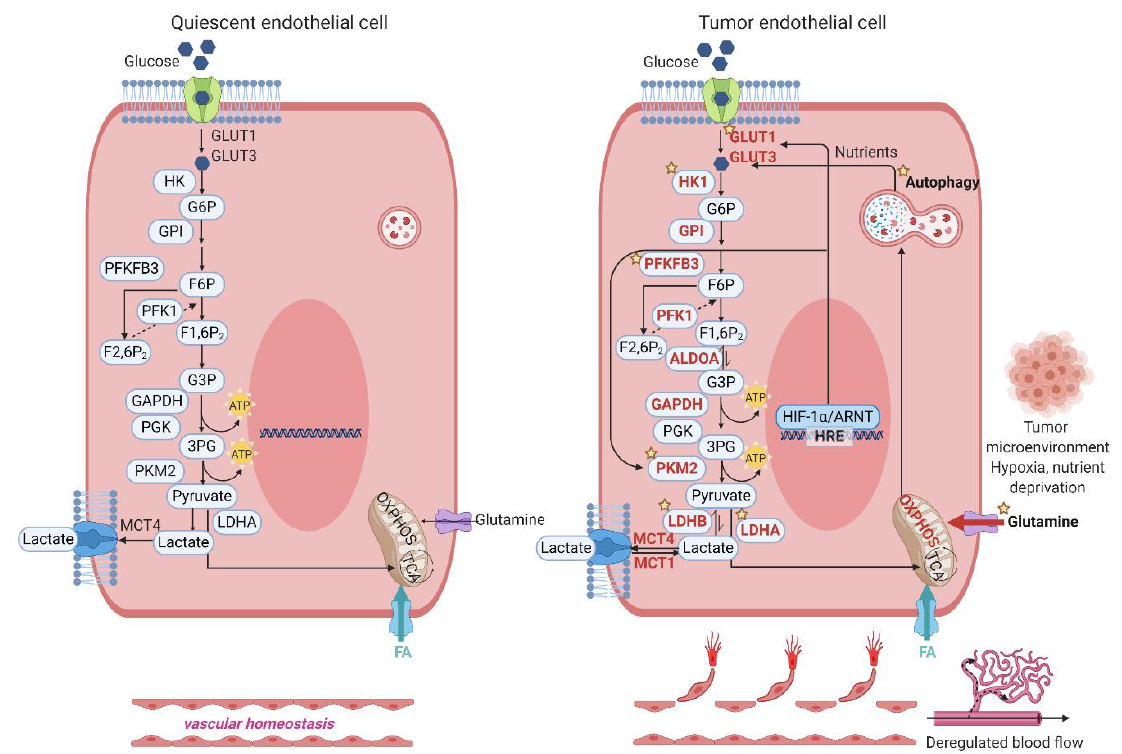
Figure 3. Tumor endothelial cells (TECs) exhibit distinct metabolic transcriptome signatures, which are linked to their angiogenic potential. Compared with quiescent ECs, TECs utilize both glycolysis and OXPHOS for energy production. TECs (tip, stalk, and immature ECs) show upregulated glycolytic genes, including glucose transporter 1 (GLUT1), glucose transporter 3 (GLUT3), hexokinase 1 (HK1), hexokinase 2 (HK2), 6-phosphofructo-2-kinase/fructose-2,6-biphosphatase 3 (PFKFB3), phosphofructokinase 1 (PFK1), aldolase A (ALDOA), glyceraldehyde 3-phosphate dehydrogenase (GAPDH), pyruvate kinase M2 (PKM2), enolase 1 (ENO1), lactate dehydrogenase A (LDHA). TECs can proliferate in a lactate-rich environment. Under hypoxia, hypoxia-inducible factor-1 alpha (HIF-1α) increases the expression of GLUT1 and GLUT3 in TECs. Autophagy is increased to promote TECs to survive and adapt to metabolic needs. The star symbol indicates the steps where chemical compounds are available and the antiangiogenic effects have been tested in preclinical or clinical settings. Red color represents the upregulated metabolic genes. FA, fatty acid; MCT1/4, monocarboxylate transporter 1/4; PGK, phosphoglycerate kinase; GPI, glucose-6-phosphate isomerase.